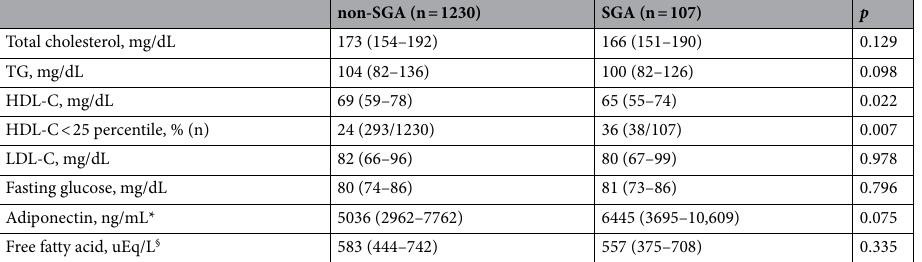
Table 2. Comparison of lipid parameters and glucose in maternal serum at gestational age of 10–14 weeks under fasting condition. TG, triglyceride; HDL-C, high-density lipoprotein cholesterol; LDL-C, low-density lipoprotein cholesterol. All values were presented by median (interquartile ranges). * Available in 625 women (577 in non-SGA group, 48 in SGA group). § Measured in 476 women (436 in non-SGA group, 40 in SGA group).